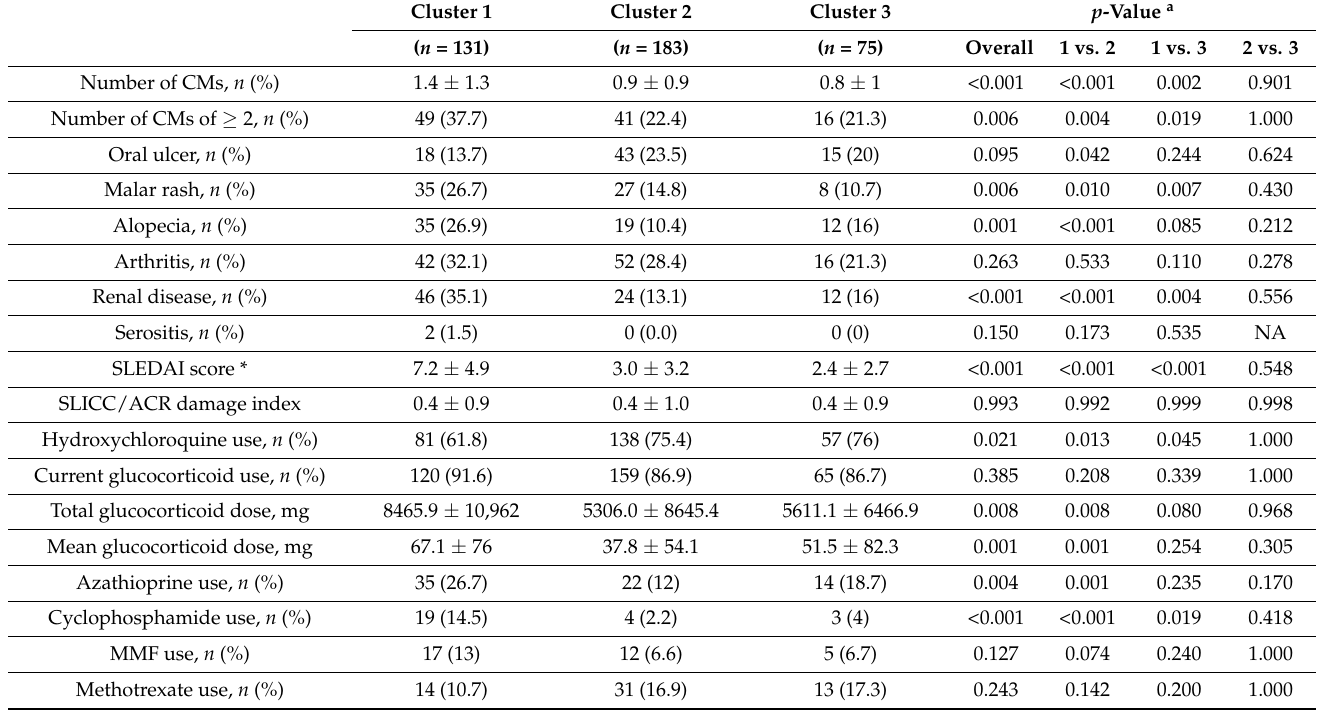
Table 3. Cumulative manifestations and treatment patterns of the SLE